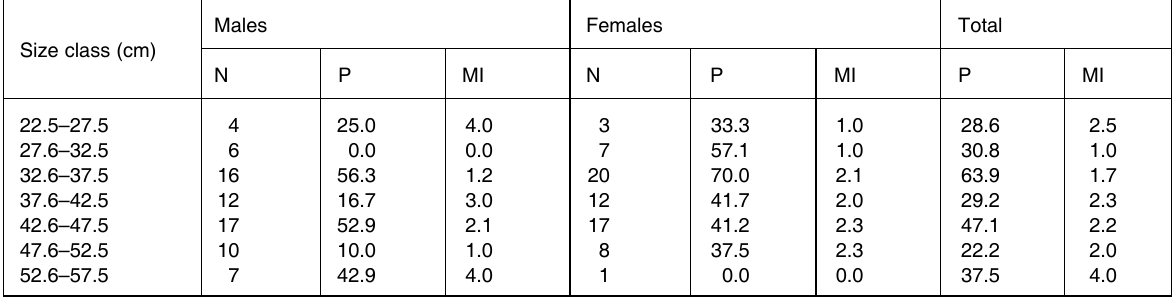
TABLE 2 The prevalence (P, % infected) and mean intensity (MI, no. of parasites per fish) of Contracaecum larvae in Clarias gariepi- nus from Lake Chivero, in relation to the standard length of the host